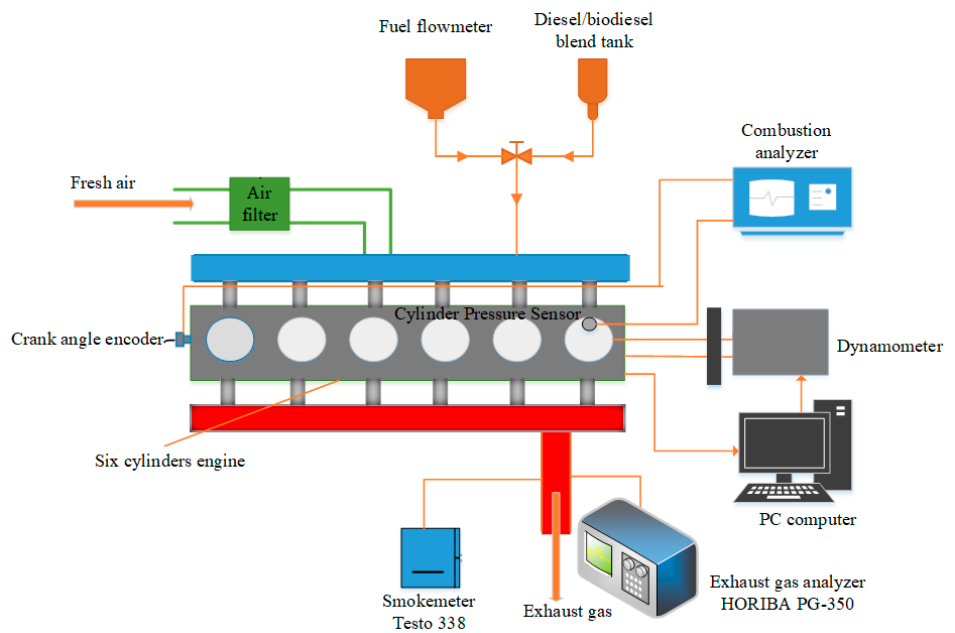
Figure 1. Schematics diagram of engine bench test and emission test experimental setup.